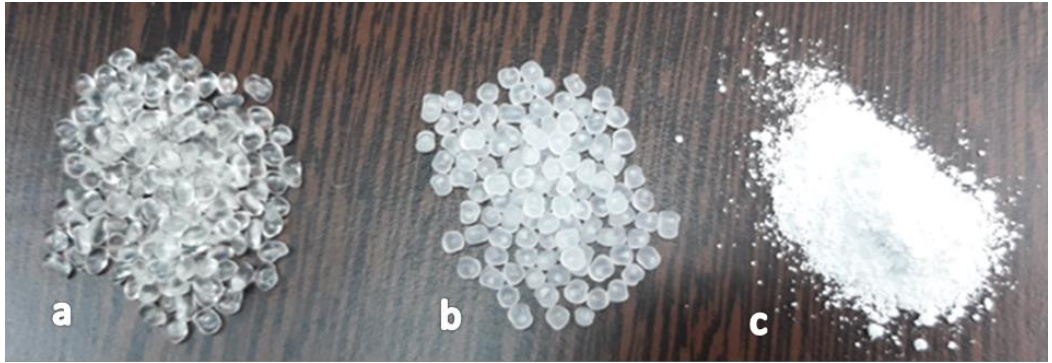
Figure 1. Raw materials used to obtain composite materials: ( a ) TPU beads; ( b ) PP beads; ( c ) BaTiO 3 powder.